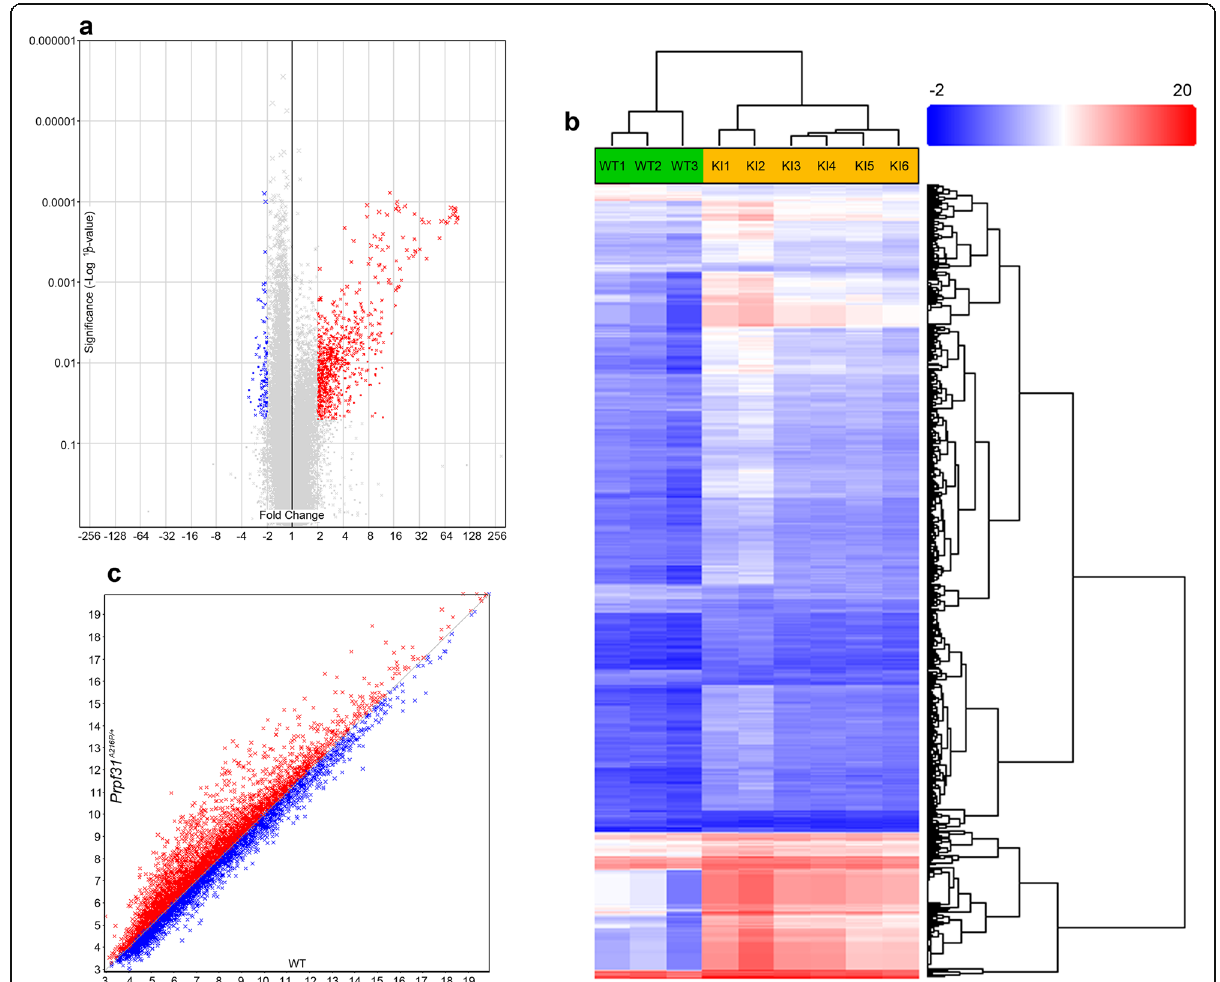
Fig. 4 Differences in the level of gene expression and alternative splicing in the RPE of Prpf31 A216P/+ mice compared to WT controls. Volcano plot ( a ) showing the genes that are upregulated (red) or downregulated (blue) in Prpf31 A216P/+ KI mice with a significance ANOVA p value < 0.05 and fold change < − 2 or > 2 when compared with WT mice. Hierarchically clustered ( b ) genes (rows) and WT or KI mice (columns) with dendrograms and flat clusters; red in the heatmap denotes upregulation while blue denotes downregulation. Scatter plot ( c ) presents the genes that are alternatively spliced in Prpf31 A216P/+ mice with lower (red) or higher (blue) splicing index when compared with WT mice (WT n = 3 and Prpf31 A216P/+ n = 6)